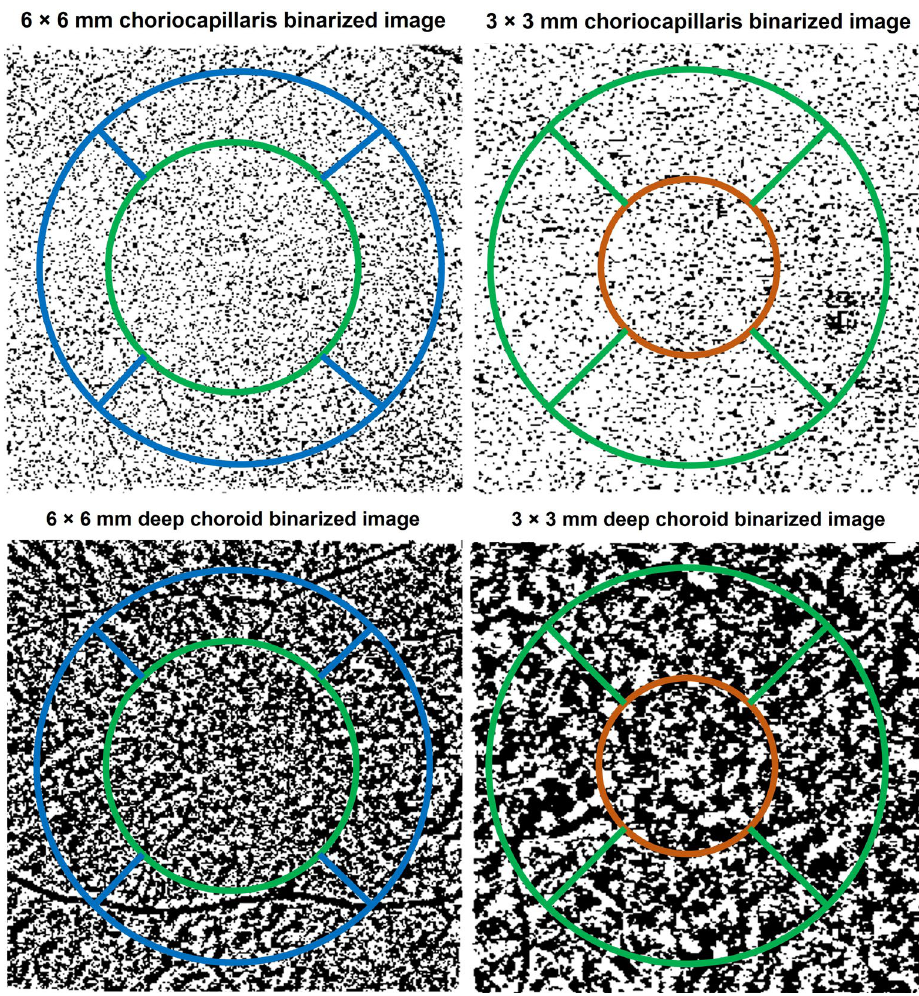
Figure 1. Example of the 6 × 6 mm (left) and 3 × 3 mm (right) binarized choriocapillaris (top) and deep choroidal (bottom) en-face image centred with modified early treatment diabetic retinopathy study (ETDRS) grid. Central/sub-foveal zone- inside orange circle, sub-parafoveal zone with quadrants- region between orange and green circles (in the left image) and sub-perifoveal zone with quadrants- region between green and blue circles (in the right image). The black pixels in the binarized choriocapillaris image represent the flow deficits. The black pixels in the binarized deep choroidal image represent the